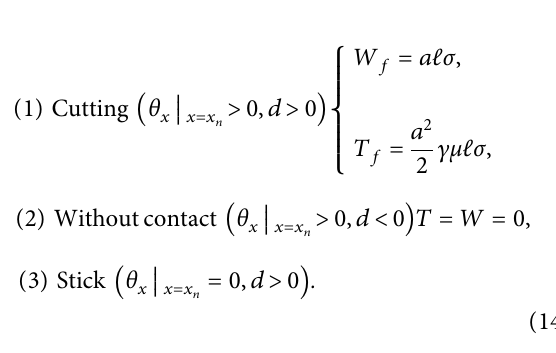
Figure 3: Schematic diagram of